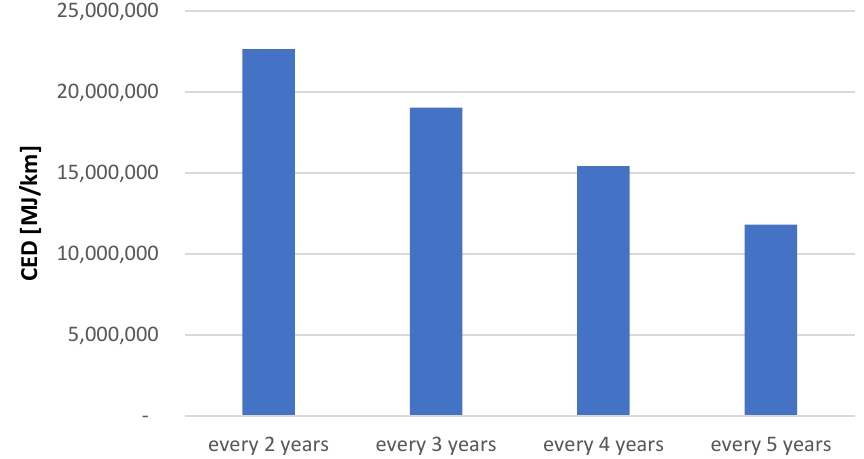
Figure 8. The cumulative energy demand of 1 km of e-road considering the different wear layer rehabilitation frequencies.